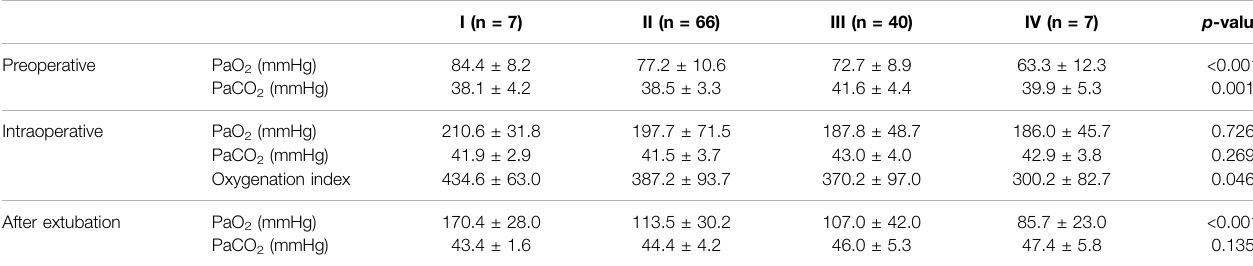
TABLE 2 | Perioperative blood gas analysis.